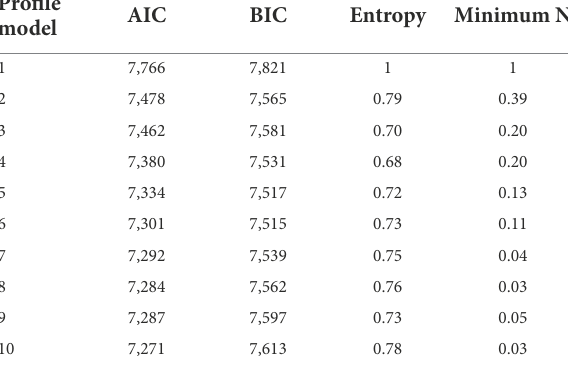
TABLE 3 Model fit indices for